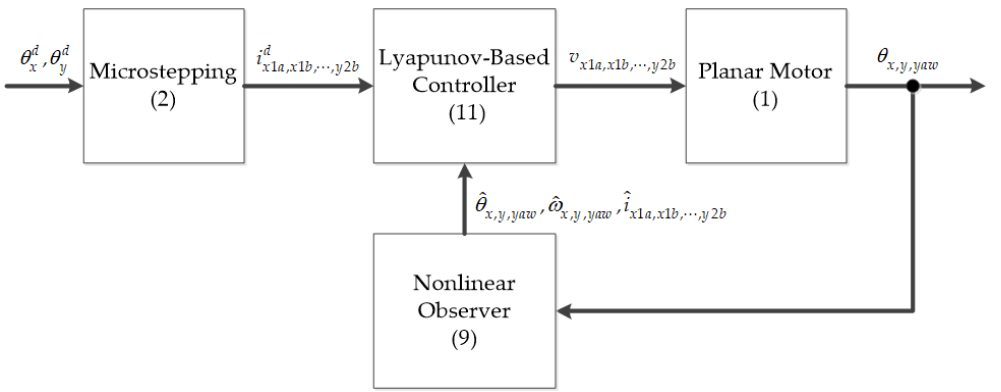
Figure 2. Control block diagram of the proposed algorithm.